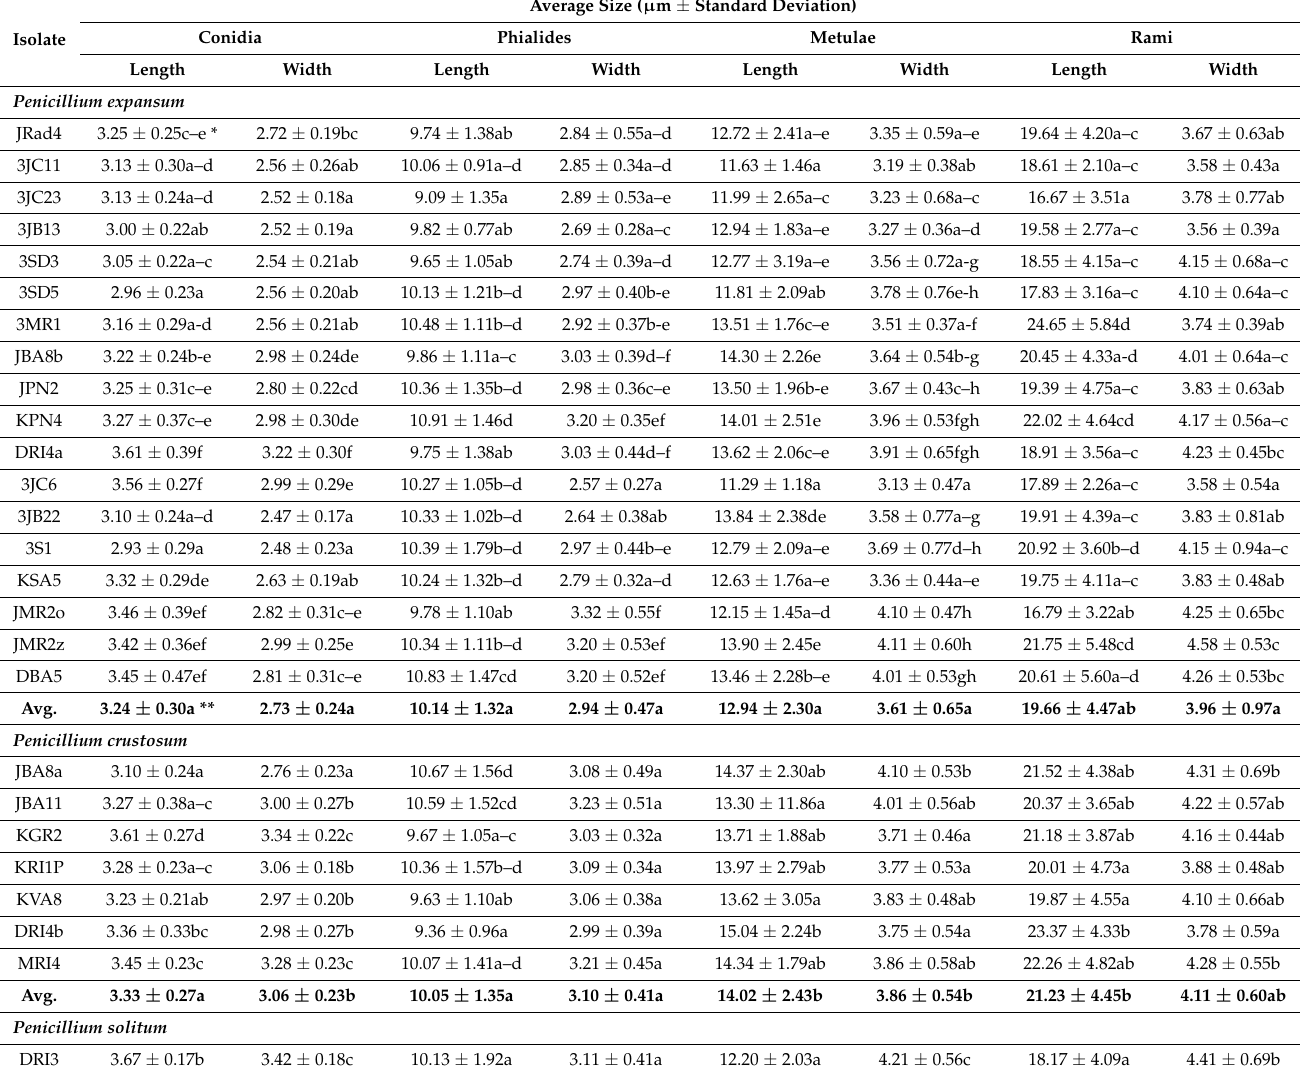
Table 4. Micromorphology of Penicillium expansum , P. crustosum and P. solitum